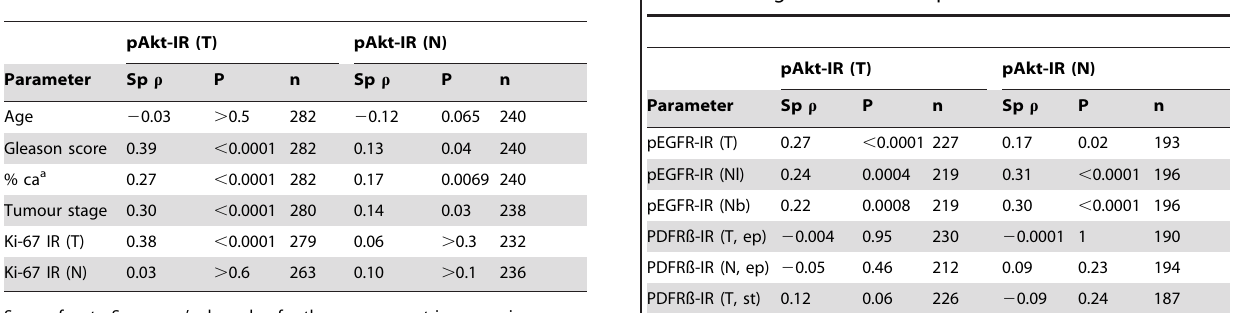
Table 2. Correlation coefficients for pAkt-IR scores with pEGFR-IR, total EGFR-IR and PDFRß-IR scores in the tumour and non-malignant tissue samples.